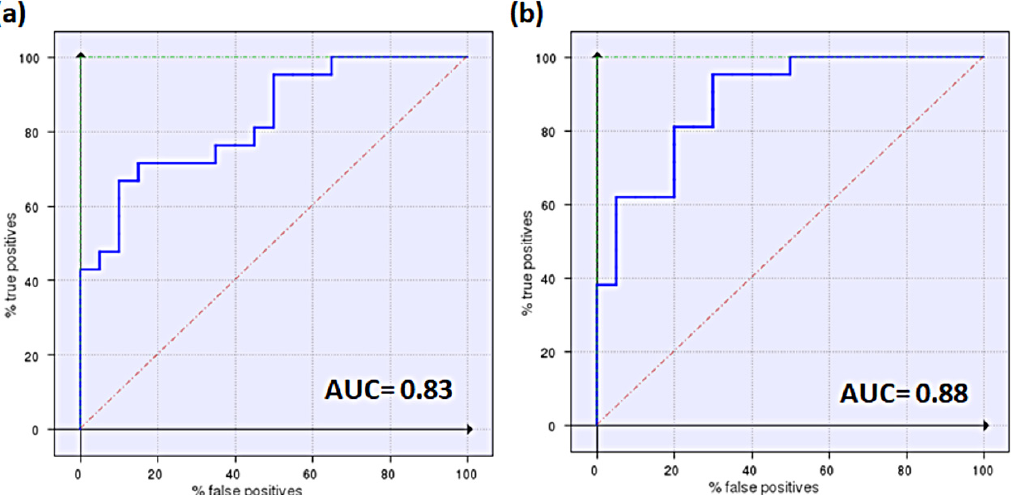
Figure 4. Enrichment plots (ROC curves) for validation of the two pharmacophores, P1 ( a ) and P2 ( b ). AUC values are also reported according to descriptors with the best performances (H*O*H for P1 and P2).